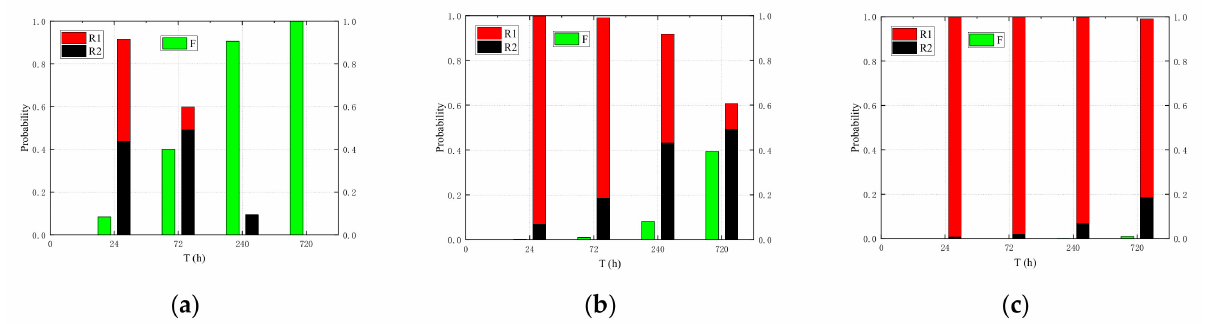
Figure 10. Probability of the system in different states.